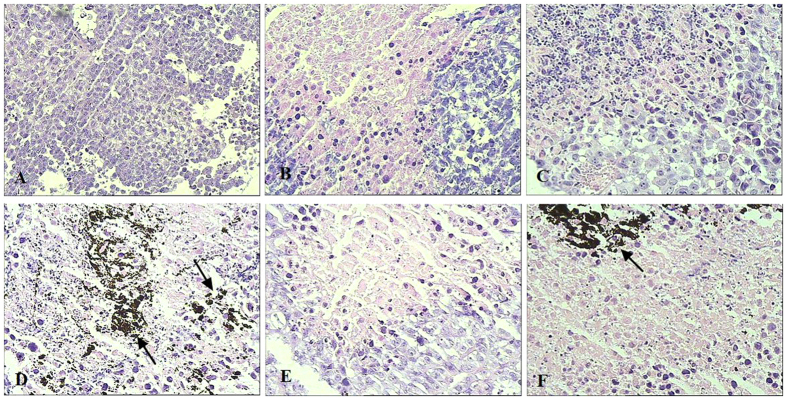
Xenograft hepatoma histopathological findings (stained with HE, ×400).(A) saline control group; (B) adriamycin group; (C) nuclide-alone group; (D) MFH-alone group; (E) nuclide-gene group; (F) nuclide-gene-MFH group.